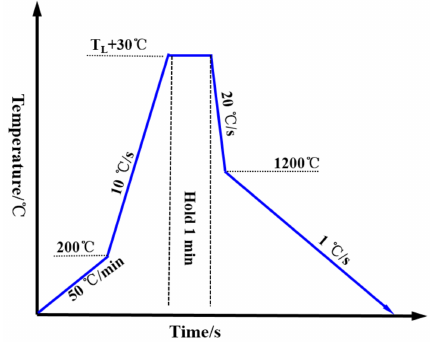
Figure 1. Thermal scheme.